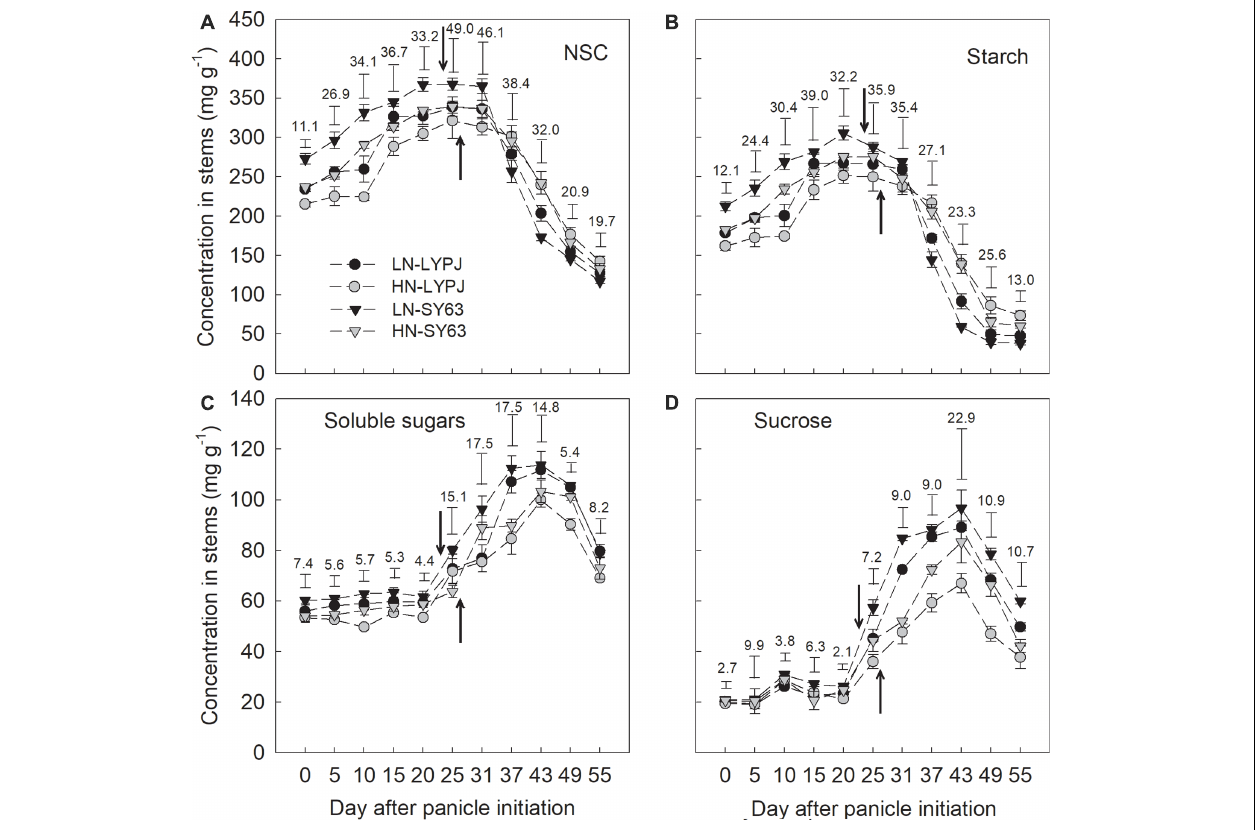
FIGURE 3 | Concentrations of NSC (A) , starch (B) , soluble sugars (C) , and sucrose (D) in the stems of LYPJ and SY63 cultivars under LN and HN treatments. Vertical bar with number represents LSD 0 . 05 for difference significance of mean among 4 combinations at an identical time point. The downward and upward arrows indicate heading date (HD) under LN and HN. Data are shown as mean ± standard error ( n =